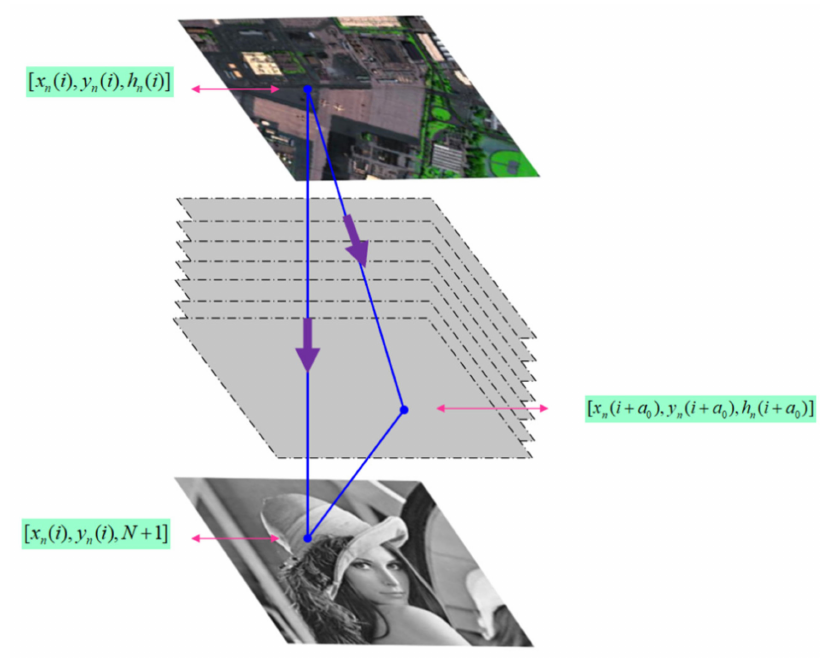
Figure 3. A triangle in space formed by three points of the image from the algorithm